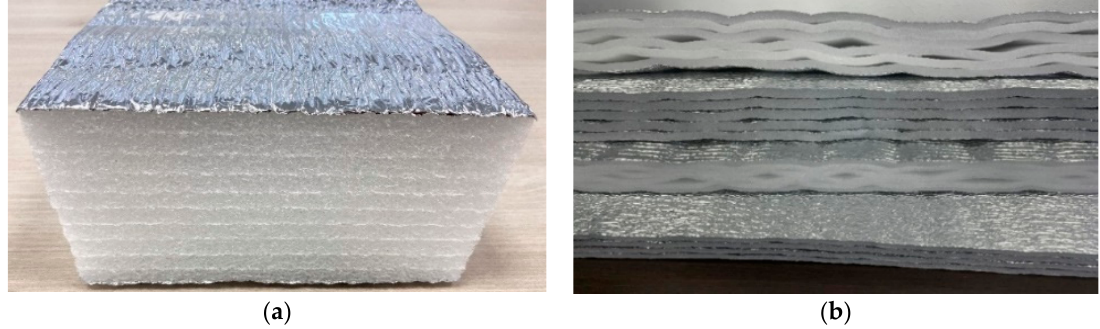
Figure 3. Polyethylene foam products: ( a ) layered products; ( b ) multi-layered products with an air gap from the air layer line.